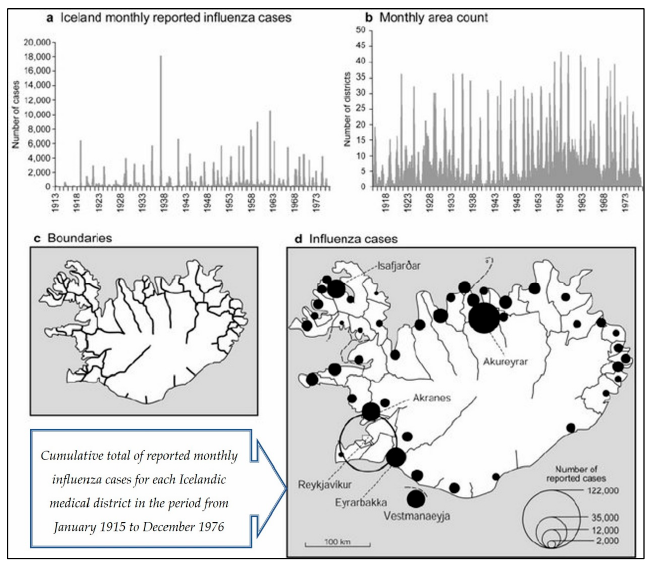
Figure 7. Reported influenza morbidity in Iceland in the period from January 1915 to December 1976. (Source: [34]). In another work, Braga et. al [36] mapped lung cancer clusters in the cities of Viterbo and Lucca, Italy. Standard methods, such as kernel and Bayesian, were used to determine disease rates at the cluster level. Brown et al., [37] used GIS as an effective tool in investigating spatial inequality of the delivery of healthcare services in Merseyside, UK. Furthermore, Wrigley [38] used GIS to model the disease-affected areas according to the demographic characteristics and the socioeconomic variables of the population. In Johnson’s work [39], prostate cancer incidence rates were modeled using GIS in New York State. In this work, infection rates (SIRs) of prostate cancer were subjected to the hierarchical modeling of Bayesian by zip code to determine the relative performance of spatial data. In this work, spatial data were linked to air quality data. In the area of integration between GIS and epidemiological techniques, Rasam et al. [40] used an exploratory analysis approach to identify patterns of spatial distribution of cholera in the Sabah area of Malaysia. In this study, cholera cases were mapped using spatial statistics within a GIS enviroment (see Figure 8). An epidemiological technique (i.e., a cohort technique) was also used to examine the disease’s spread. As a result, it became clear that the disease was easily transferred from person to person, especially in the area within 1500 meters from the patient location and with contaminated water. Hence, this study showed that GIS is considered an effective epidemiological technique for mapping patterns of the spatial distribution and directions of disease. Commented [MW3]: Please check intended meaning is retained.